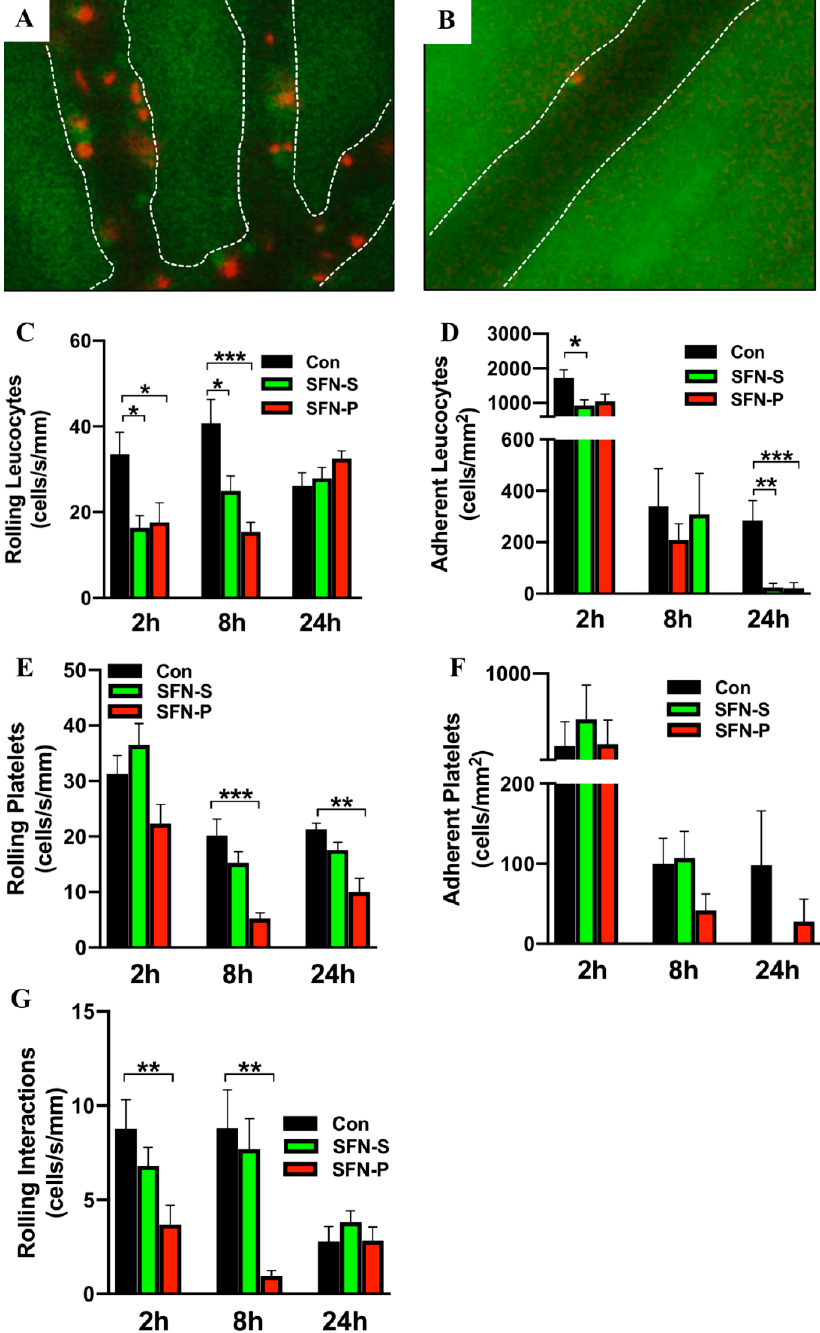
Figure 2. Representative intravital microscopy (IVM) images of leukocytes (red) and platelets (green) in postischemic intestinal postcapillary venules of ( A ) control and ( B ) SFN-treated mice, white lines mark the vascular boarder. ( C – F ) Leukocyte and platelet trafficking was analyzed via rolling ( C,E ) and adherence ( D,F ) in postischemic intestinal postcapillary venules of control (CON), systemically treated (SFN-S) and platelet treated (SFN-P) mice with 2 h, 8 h and 24 h reperfusion. ( G ) Rolling interactions of leukocytes and platelets in control (CON), systemically treated (SFN-S) and platelet treated (SFN-P) mice with 2 h, 8 h and 24 h reperfusion. All data are presented as mean values ± SEM, n= 9-11 animals per group. Significance is indicated by the following symbols: * = p < 0.05, ** = p < 0.01, *** = p < 0.001 versus Con .